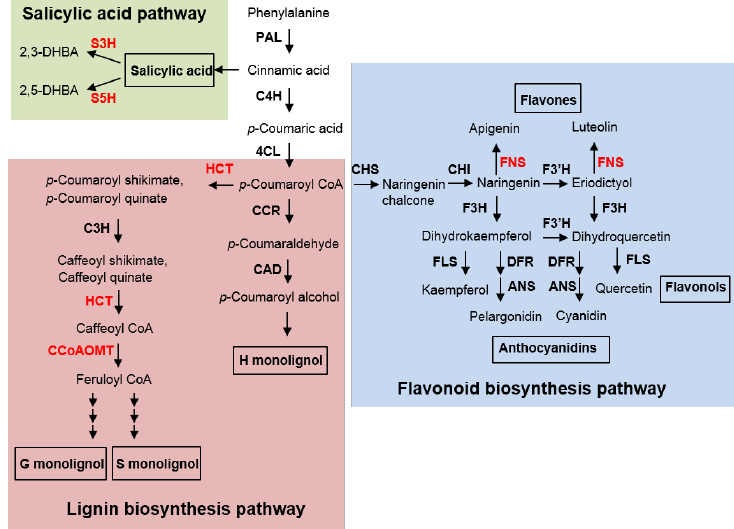
Figure 1. The phenylpropanoid pathway, modified according to previous studies [21,28]. 4CL, 4-